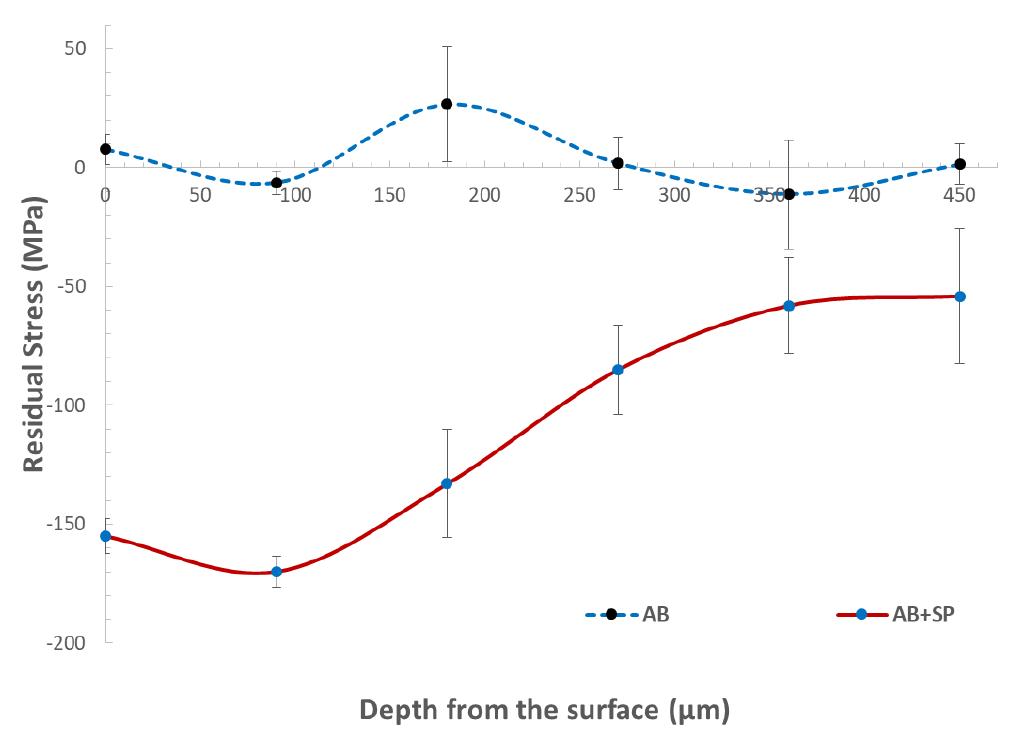
Figure 12. The in-depth residual stress profile from the AlSi10Mg sample surface.